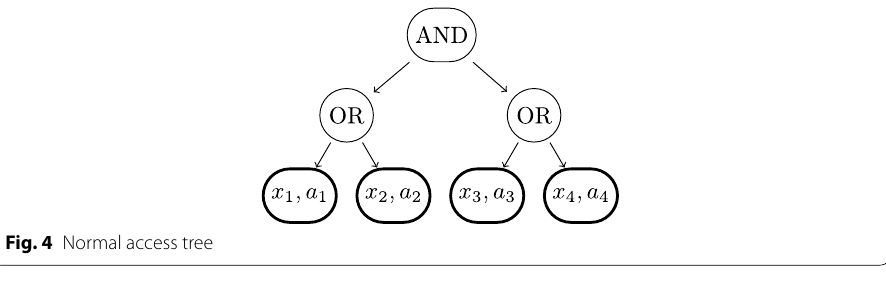
Fig. 4 Normal access tree